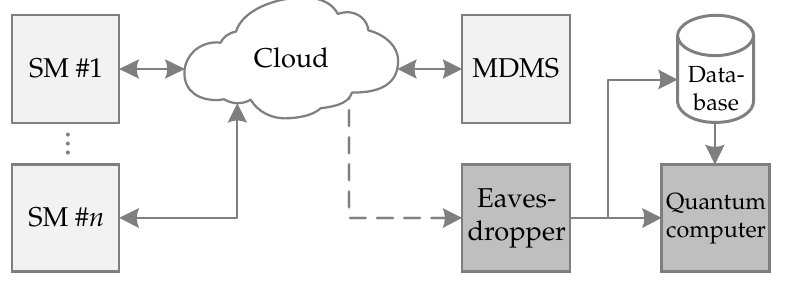
Figure 1. A typical security breach scenario in which an eavesdropper performs a sniffing attack and makes use of a quantum computer to decipher the overheard SM data.